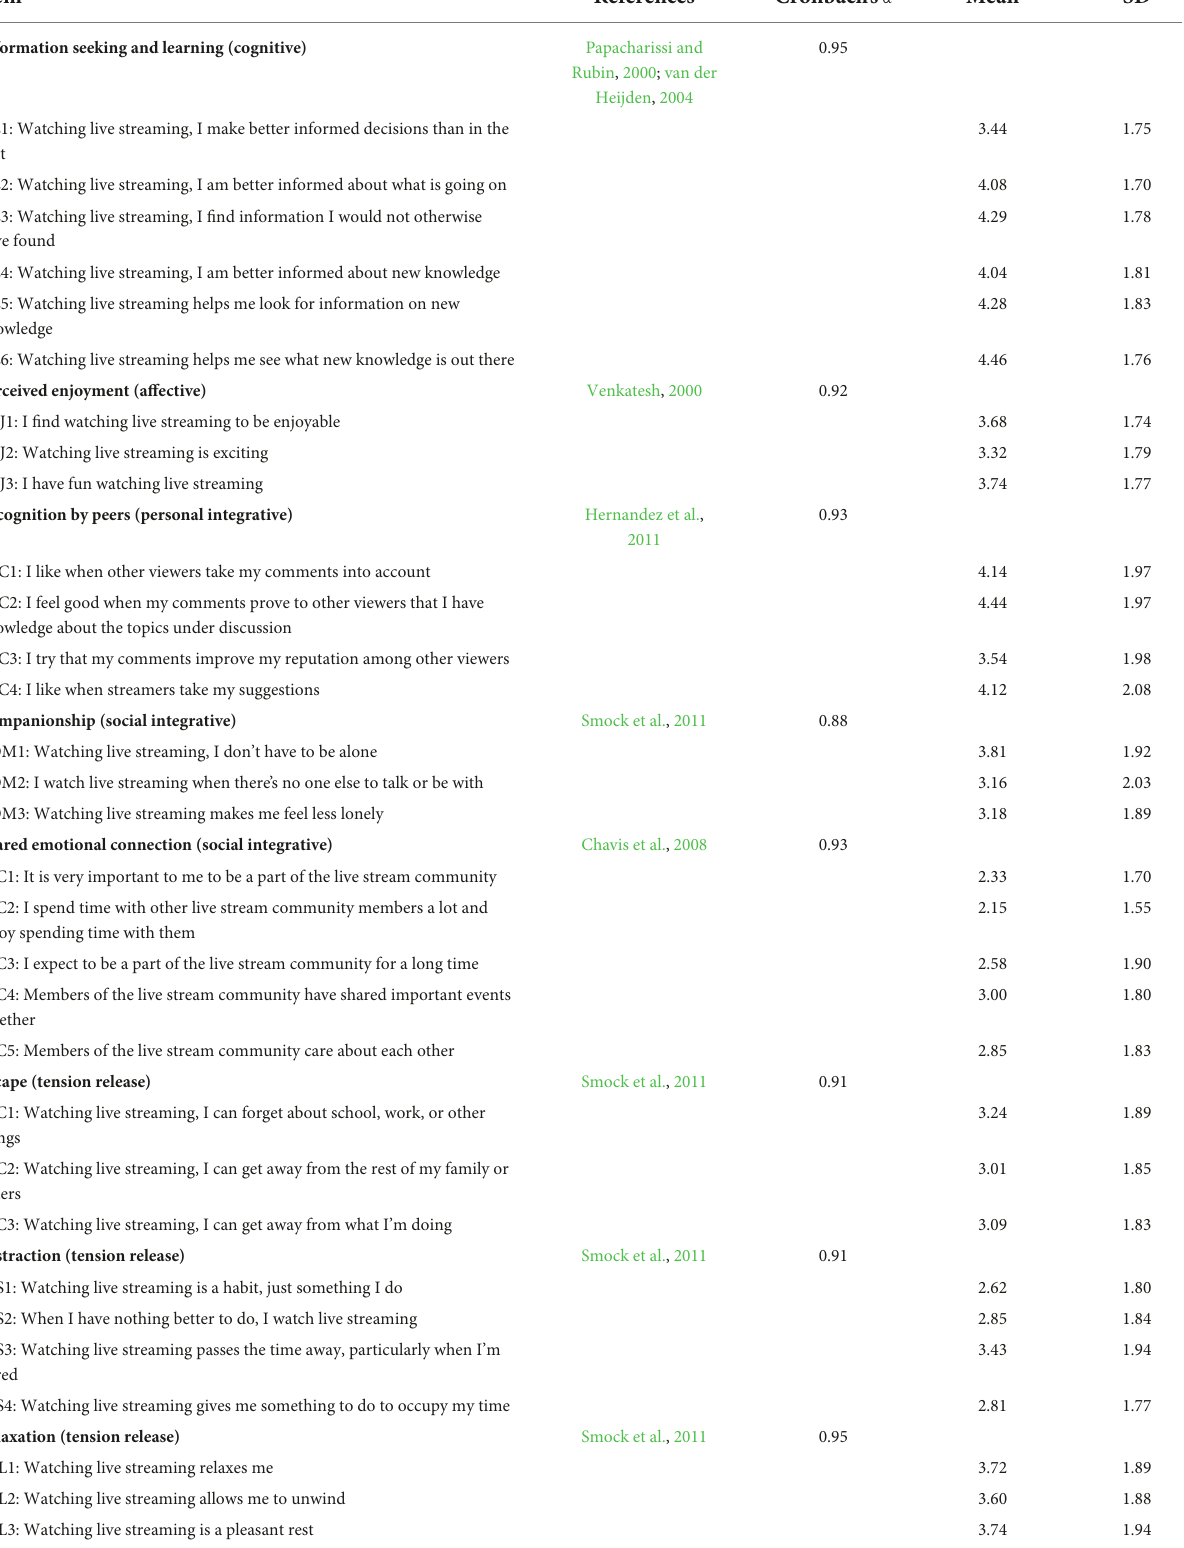
TABLE 2 Construct measurement and summary